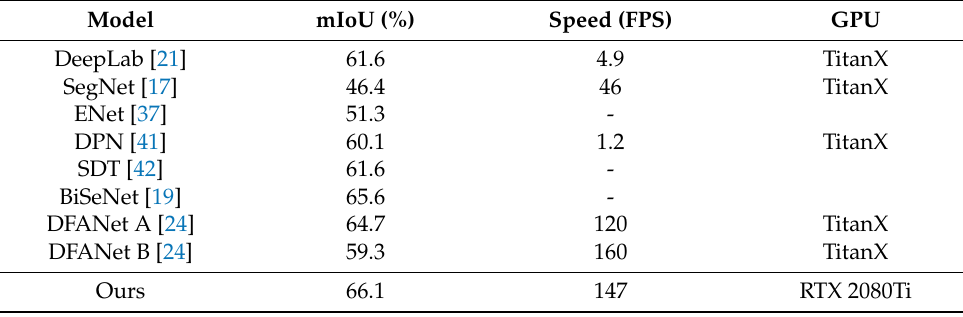
Table 3. Comparison of overall performance on